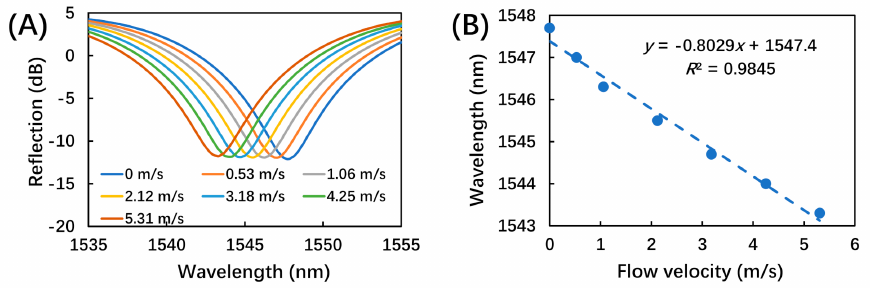
Figure 4. The responses of the breath sensor upon airflows at different flow velocities. ( A ) Reflec- tion spectrum as a function of wavelength at different flow velocities; ( B ) linear fitting of the dip wavelength ( ∼ 1545 nm) as a function of flow velocity.